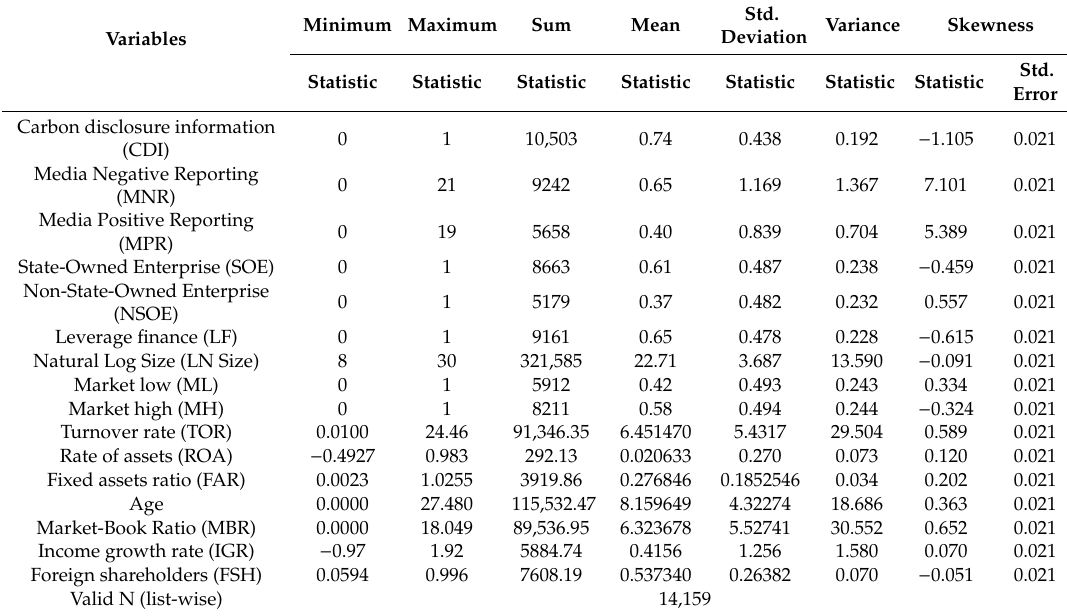
Table 2. Descriptive